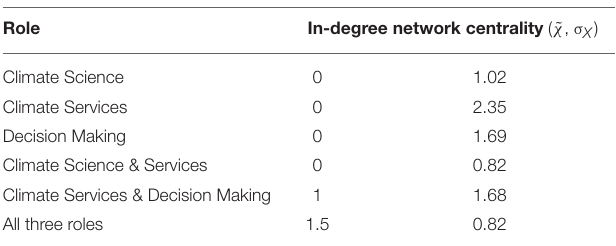
TABLE 4 | Network